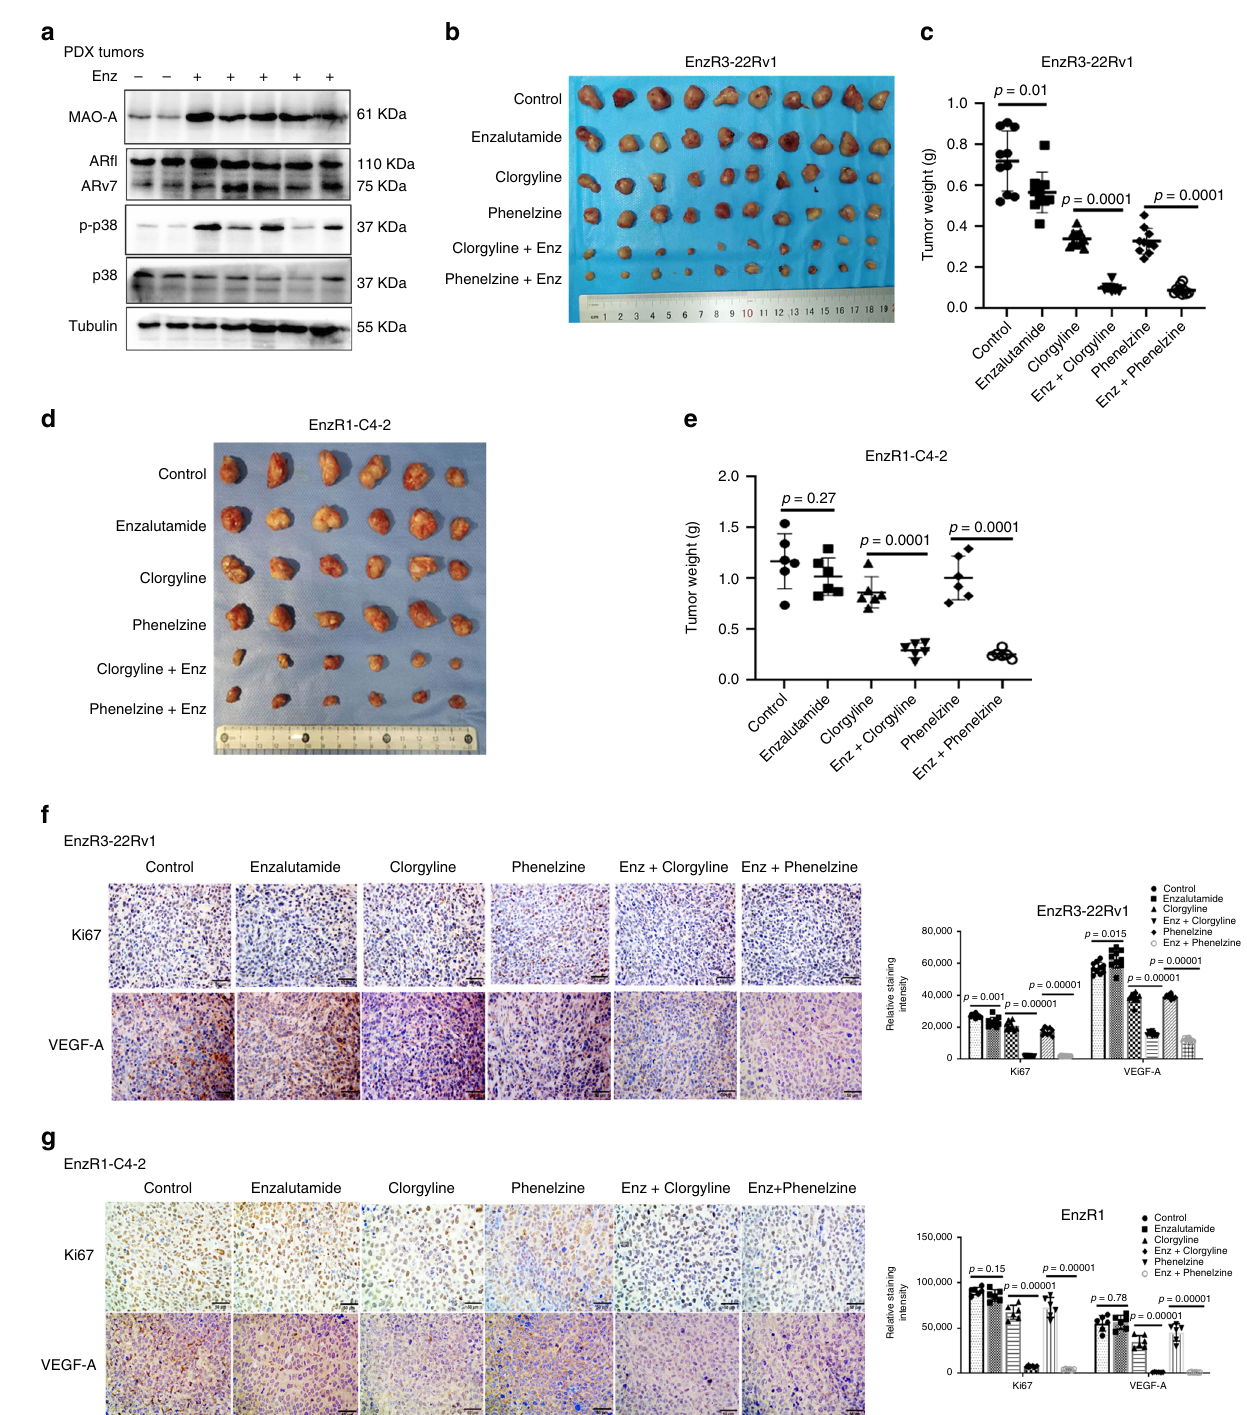
Fig. 6 Clorgyline and phenelzine, inhibitors of MAO-A, can overcome Enz resistance. a The in vivo PDX-PCa mouse model data revealed that injection with Enz (30 mg/kg/every other day) increased the MAO-A, ARv7, and p-p38 level. b , c Mice ( n = 10) implanted with EnzR3-22Rv1 xenografts were treated with vehicle control, Enz (30 mg/kg), clorgyline (10 mg/kg), phenelzine (30 mg/kg), Enz + clorgyline (30 mg/kg + 10 mg/kg), or Enz + phenelzine (30 mg/kg + 30 mg/kg). After sacri fi ce, tumors of the six groups were collected and weighed. d , e Mice ( n = 6) implanted with EnzR1-C4-2 xenografts received the same treatments as EnzR3-22Rv1. After sacri fi ce, tumors of the six groups were collected and weighed. f IHC staining of Ki67 and VEGF-A in EnzR3-22Rv1 tumors were performed; (scale bar = 50 μ m). g IHC staining of Ki67 and VEGF-A in EnzR1-C4-2 tumors were performed; (scale bar = 50 μ m). Data represent the mean ± SEM, error bars represent SEM. p -value was determined by two-tailed paired t